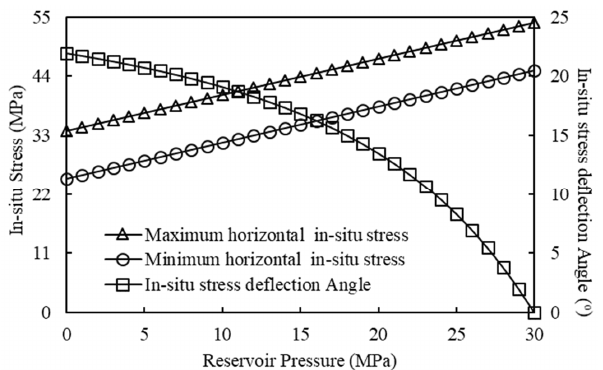
Figure 4. The evolution of induced mechanical parameter with pressure decline.